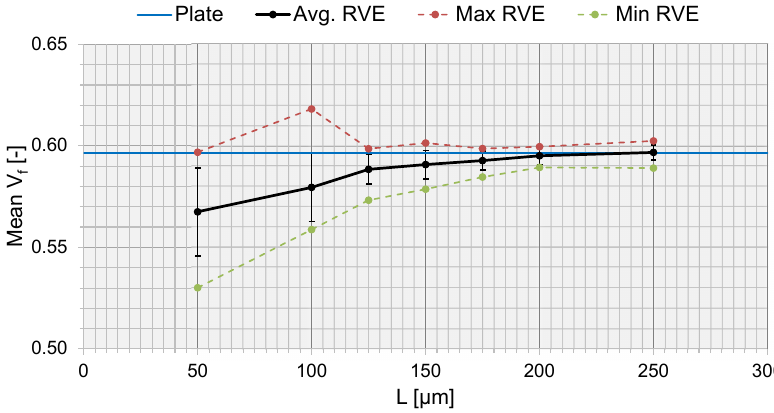
Figure 11. The fiber volume fraction, V f , as a function of RVE side length, L .